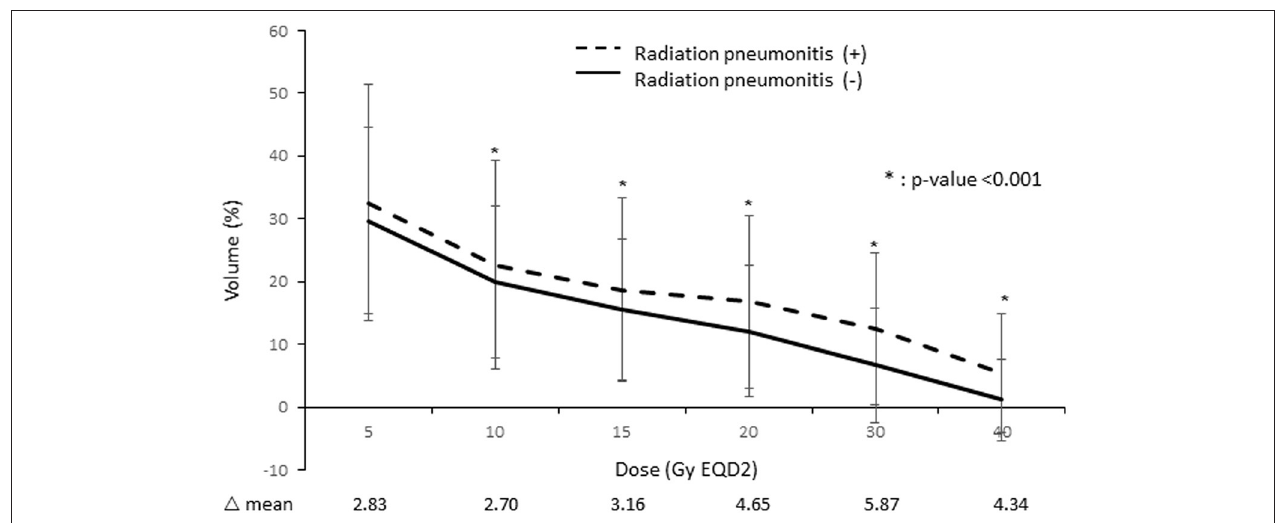
FIGURE 2 | Comparison of the lung dose-volume histogram between patients who developed radiation pneumonitis and those who did not.